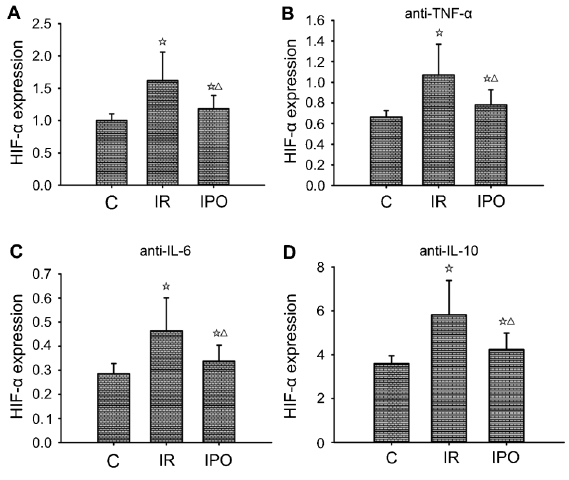
Figure 6. Effects of anti-TNF- a , anti-IL-6, and anti-IL-10 treatment on hypoxia-inducible factor-1 a (HIF-1 a ) expression in skeletal muscle ischemia-reperfusion (IR) injury that occurs after 3 h ischemia and 3 h reperfusion. A , Quantification of HIF-1 a expression. B , Effect of anti-TNF- a on the expression of HIF-1 a . C , Effect of anti-IL-6 on the expression of HIF-1 a . D , Effect of anti-IL-10 on the expression of HIF-1 a . Data are reported as means±SD. q P , 0.05 vs sham-operated group (C); g P , 0.05 vs IR group (one-way